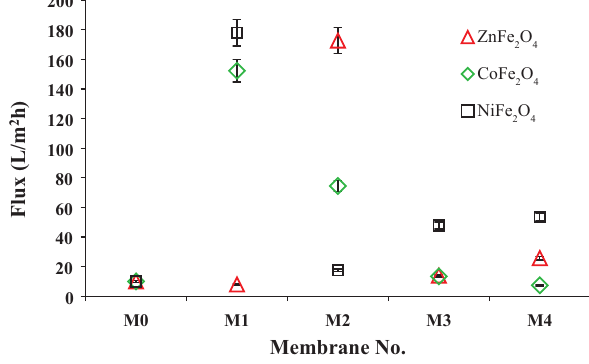
Figure 8: Pure water flux of the pure PES membrane and PES/CoFe pressure.